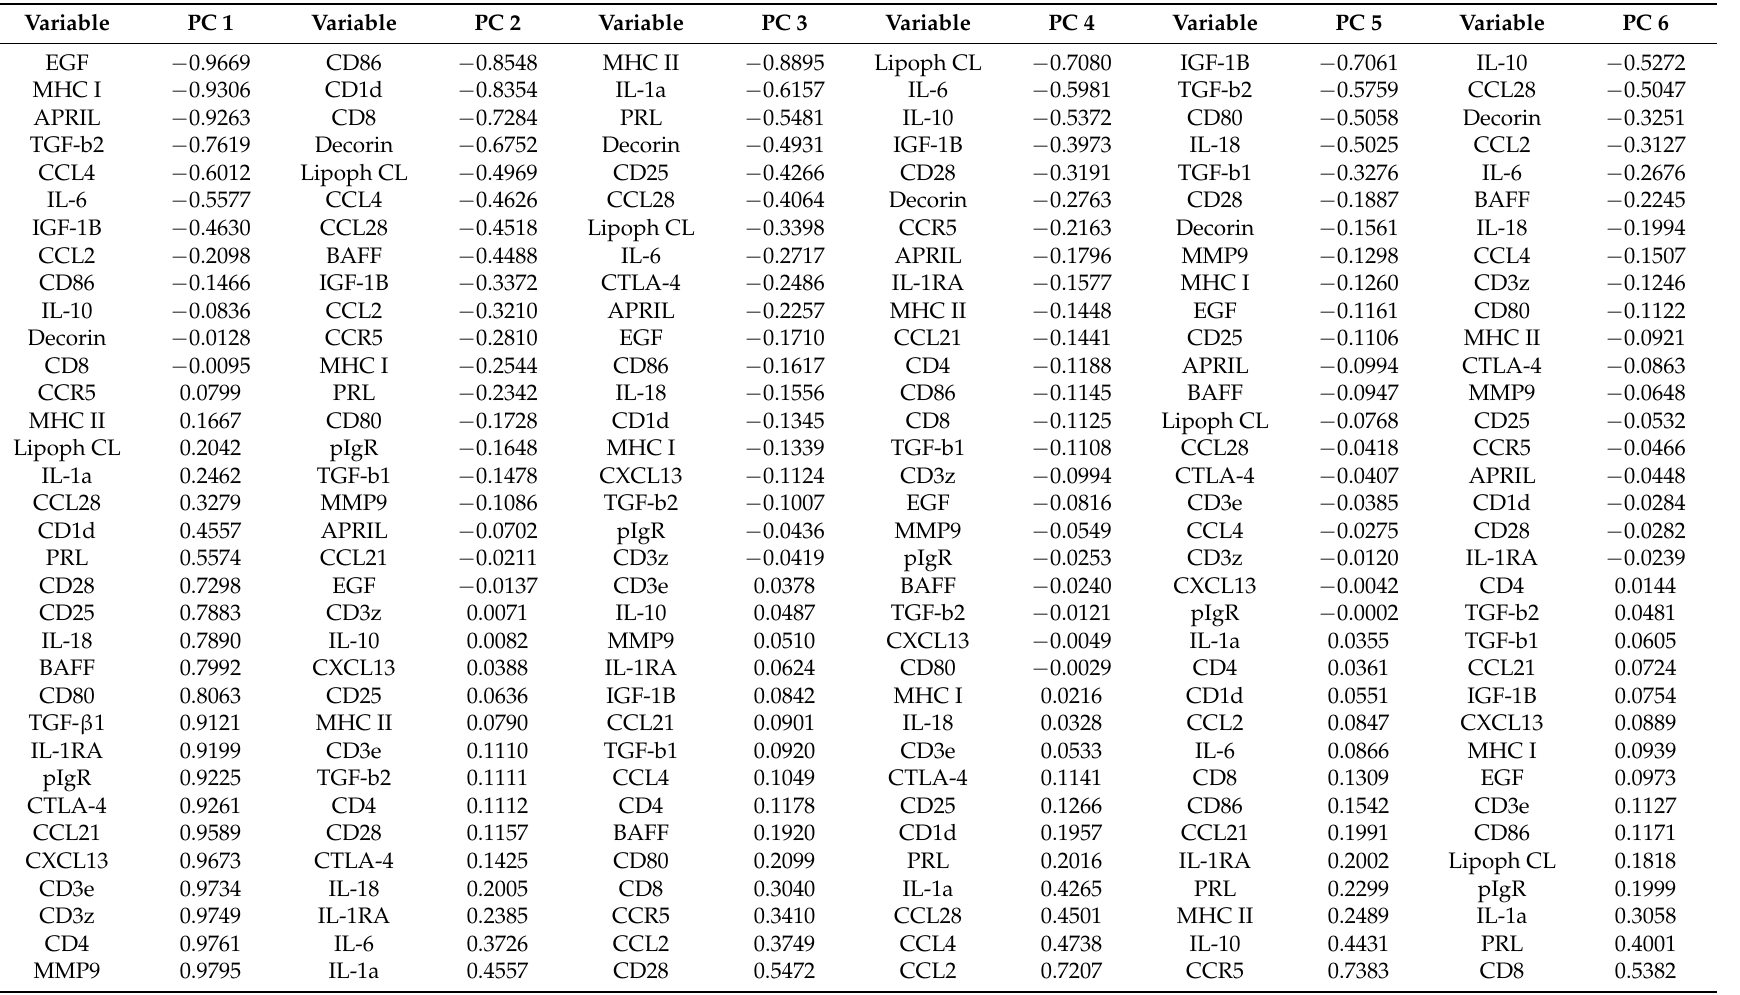
Table 2. Transcript Loadings to Immune Cell Cluster Principal